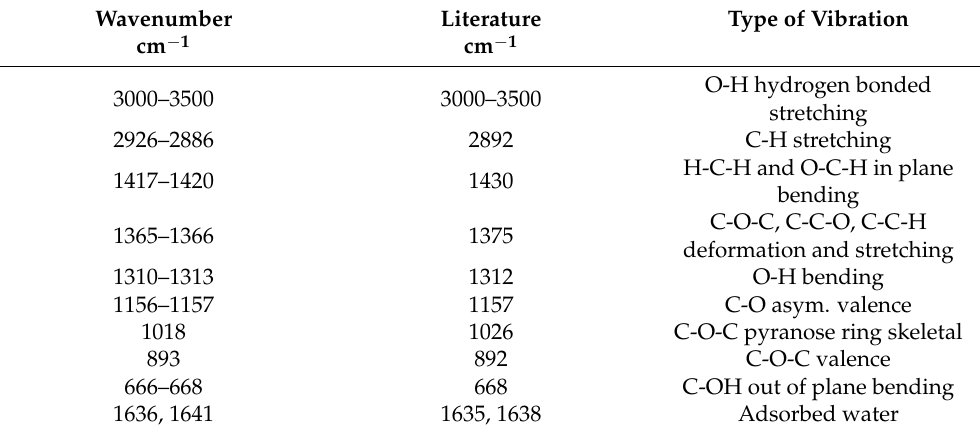
Table 3. Characteristic absorption peaks in the infrared spectrum of the viscose fibres and literature reference values for cellulose